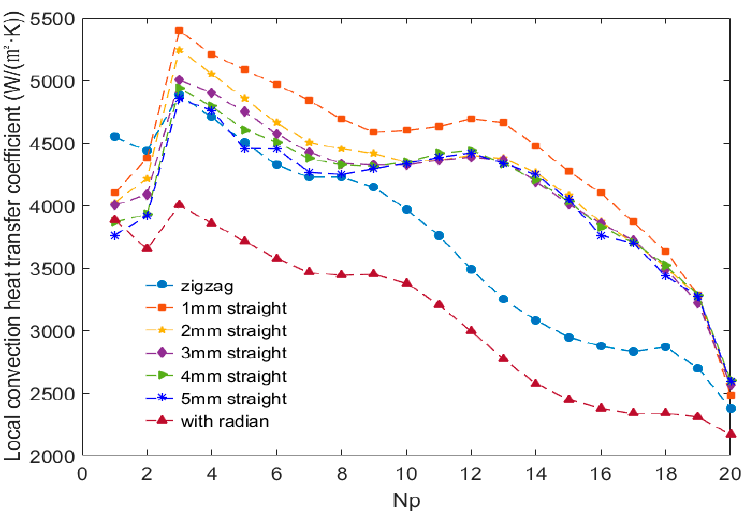
Energies 2019 , 12 , x FOR PEER REVIEW Figure 6. Velocity vectors for different channel shapes. Figure 6. Velocity vectors for di